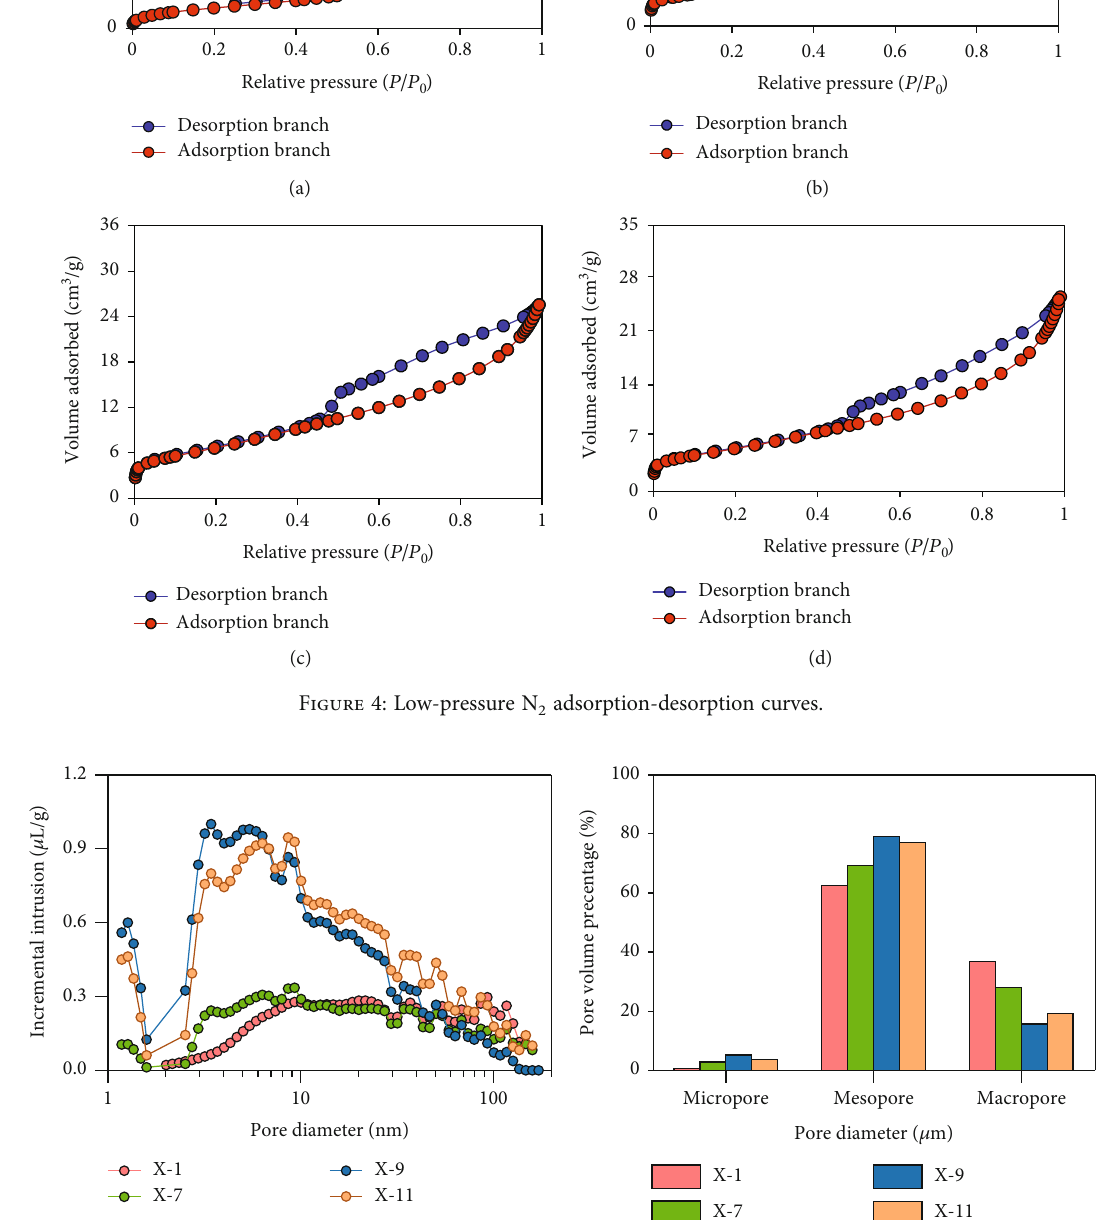
adsorption with DFT. (b) Proportions of micropores ( < 2nm), mesopores (2-50nm), 2